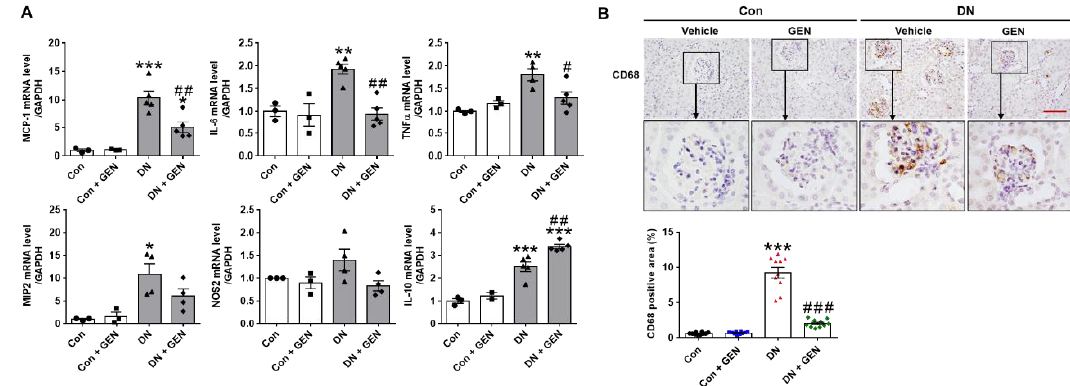
Figure 4. Geniposide decreases renal inflammation and macrophage infiltration in DN. ( A ) Relative mRNA levels of pro-inflammatory cytokines (TNF α , IL-6, NOS2), chemokines (MCP-1, MIP2) and anti-inflammatory cytokine (IL-10) were determined by real-time PCR analysis. Relative mRNA expression was normalized to that of GAPDH ( n = 3–5). ( B ) Kidney sections were processed for immunostaining of CD68, a macrophage marker, and the representative images were shown. The CD68-positive area (%) was calculated using ImageJ software ( n = 3). Data are presented as the mean ± SEM. One-way ANOVA was used for statistical analysis followed by Bonferroni’s multiple comparisons. * p < 0.05, ** p < 0.01, *** p < 0.001 vs. control mice; and # p < 0.05, ## p < 0.01, ### p < 0.001 vs. DN mice. Scale bar, 50 µm.